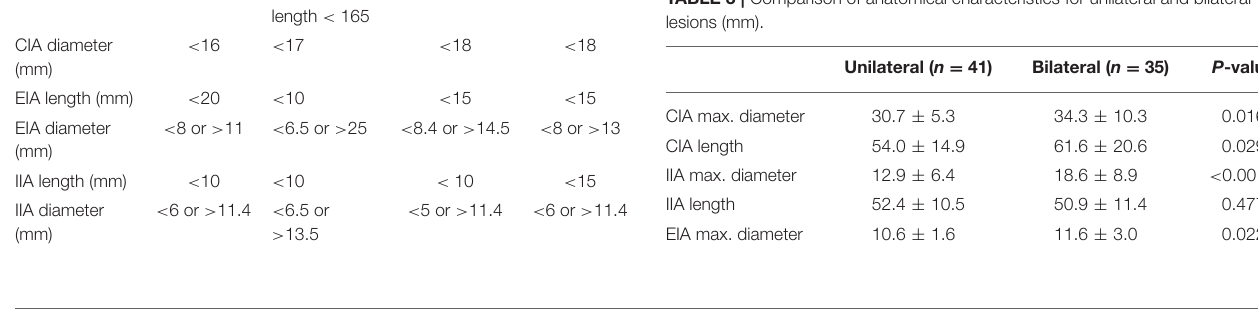
TABLE 2 | Anatomical characteristics of aortoiliac aneurysms of Eastern Asian patients